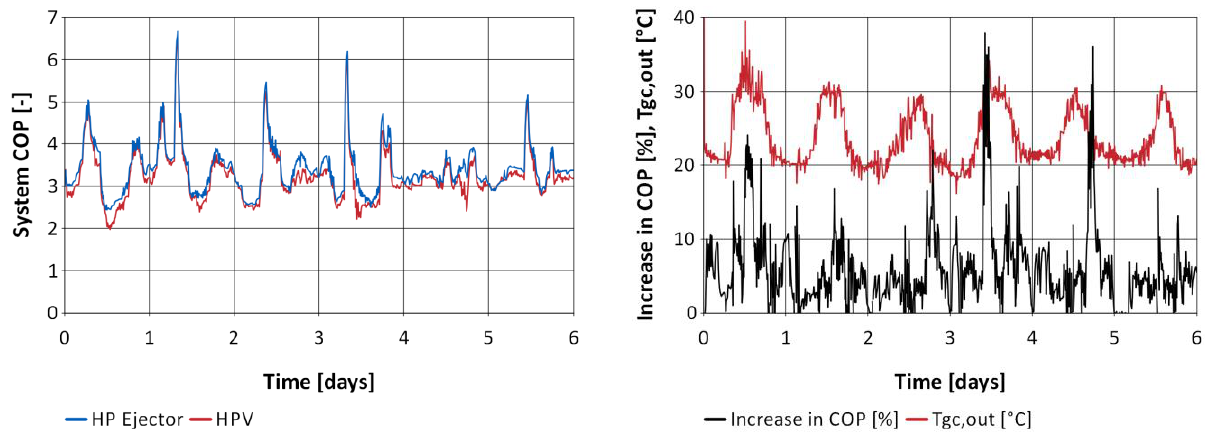
Figure 11. System COP in the case the HP ejector is utilized compared with the ejector-less configuration ( left ) and increase in system COP as a function of gas cooler outlet temperature ( right ).